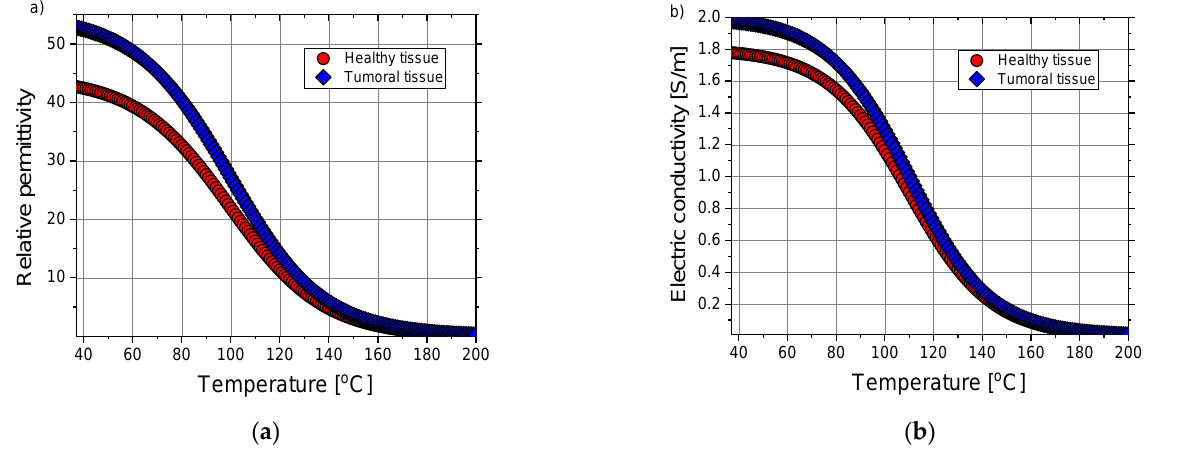
Figure 3. The temperature dependence of ( a ) relative permittivity and ( b ) electric conductivity of the healthy (red circles) and tumoral liver tissue (blue diamonds). Plots are obtained by using expressions (2) and (3) with coefficients taken from the literature [68].